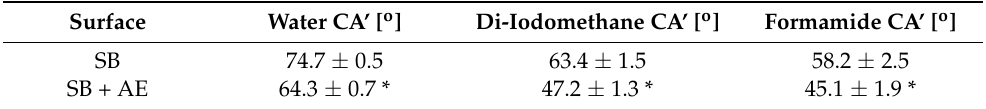
Table 3. Apparent contact angles for the three liquids used on the different c.p. Ti surfaces. Values are mean ± standard deviation. Statistical differences vs. smooth surfaces for each column are indicated by single asterisk symbols ( p < 0.05).